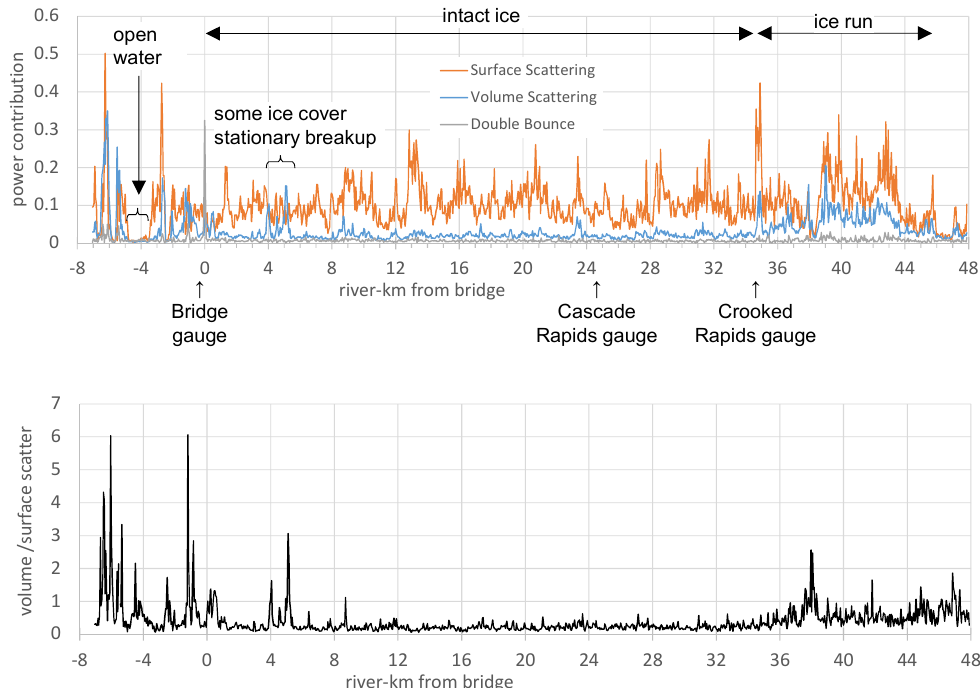
Figure 9. Longitudinal profile of averaged backscatter components (top panel) and ratio of volume scattering/surface scattering (bottom panel).